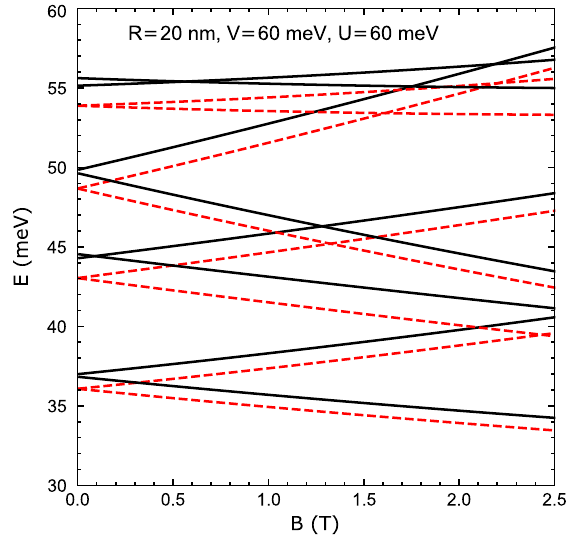
FIG. 9. Zeroth-order (red) and first-order (black) energy levels for the described model with the boundary potential U ð x; y Þ (the real boundary will be some complicated function of r